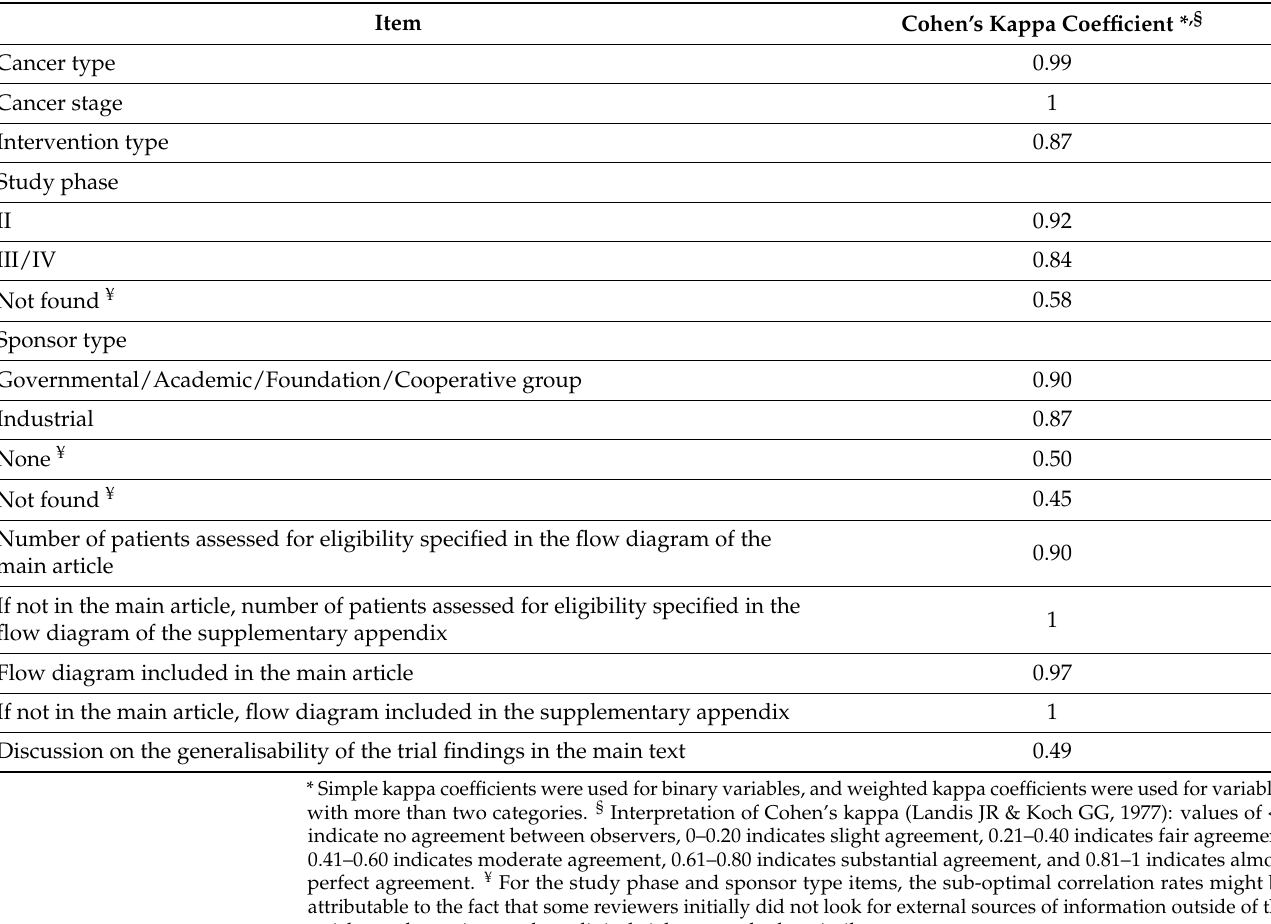
Table 3. Correlation rates between reviewers.